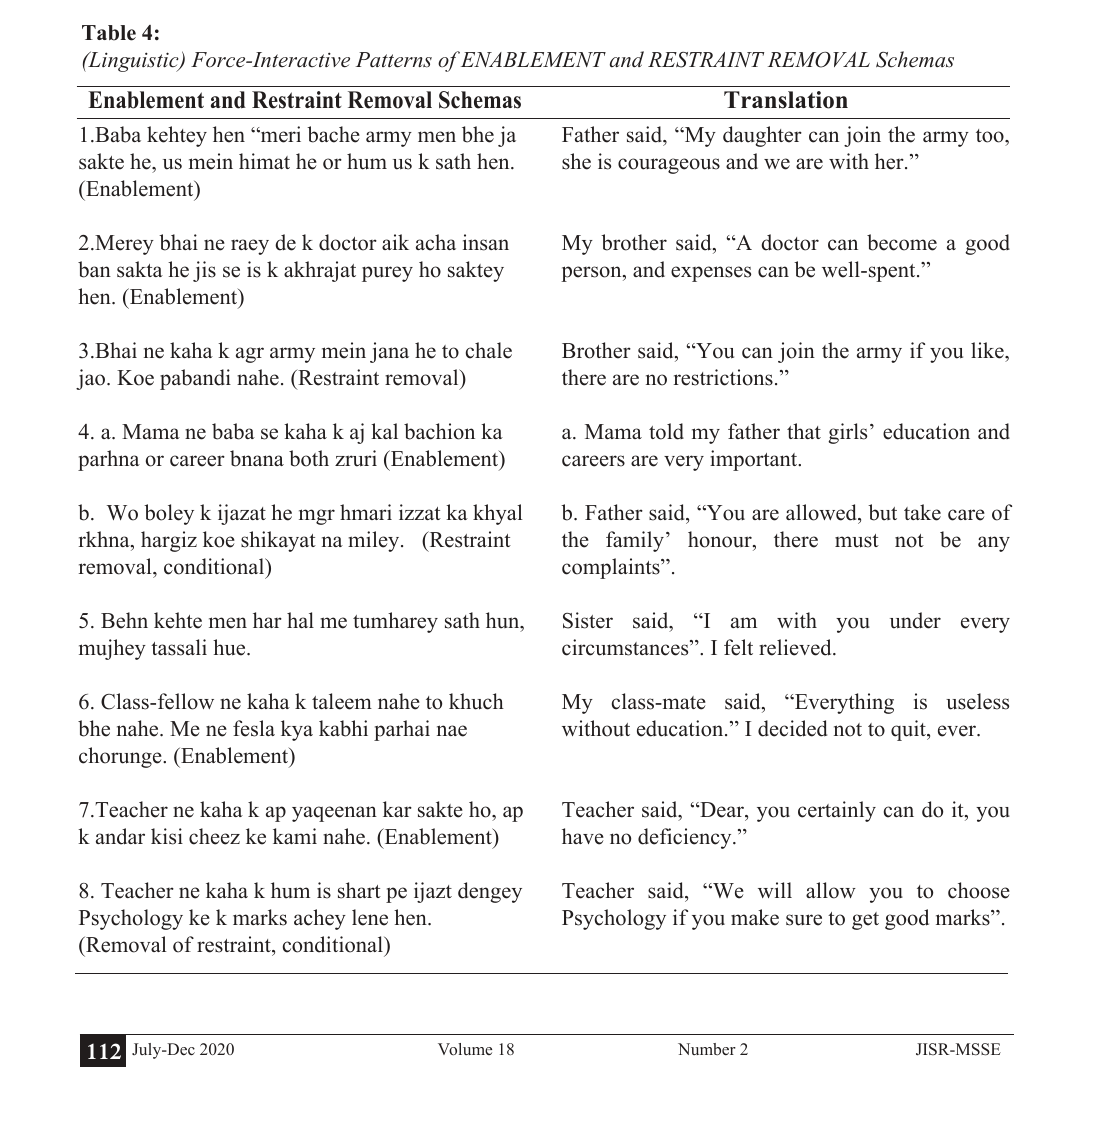
(Linguistic) Force-Interactive Patterns of ENABLEMENT and RESTRAINT REMOVAL